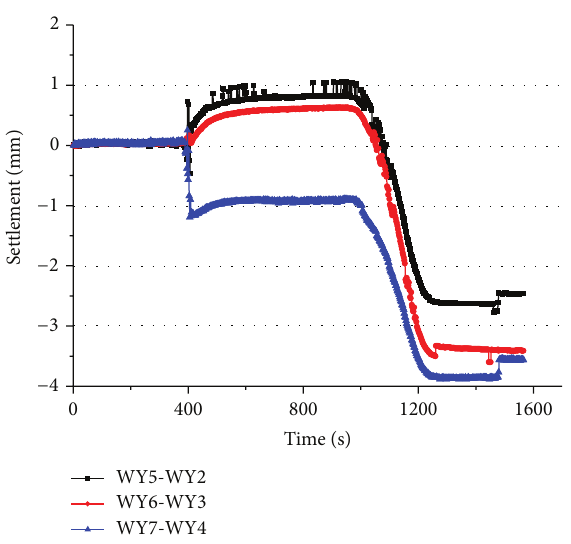
Figure 11: The settlement of layer number 5.